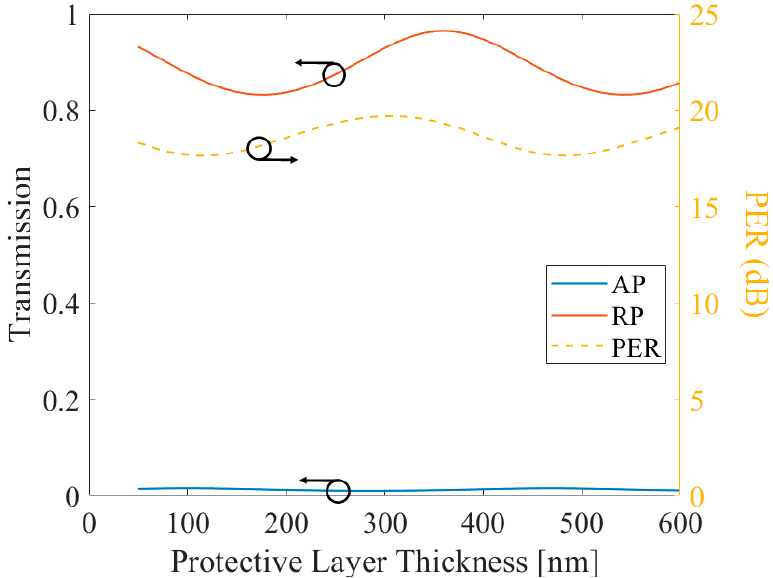
Figure 8. The AP component transmission, RP component transmission, and their PER of the corrugated surface protective layer applied MSCRA in terms of protective layer thickness.